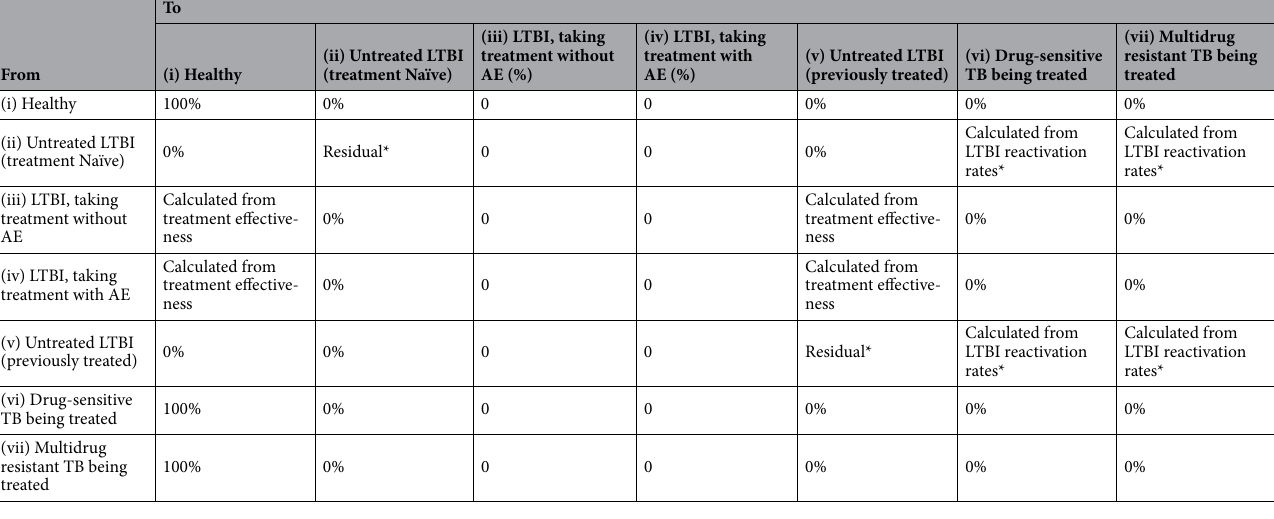
Table 1. Transition probabilities. AE Adverse event, LTBI Latent tuberculosis infection. *Values were updated every